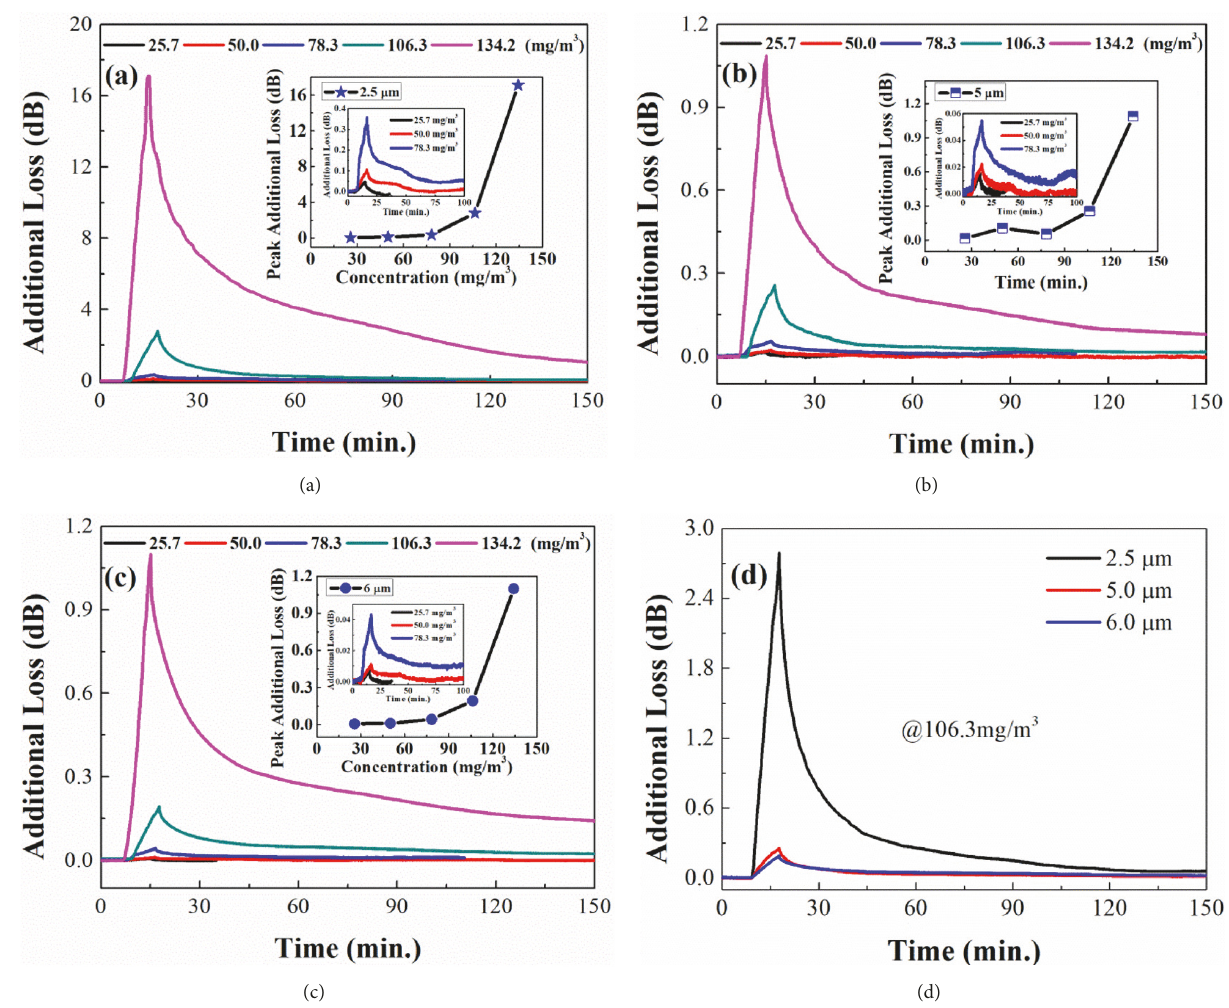
Figure 6: Responses of coated OMF sensor at different concentrations of AMCs from 25.7 to 134.2 mg/m 3 with three different diameters of